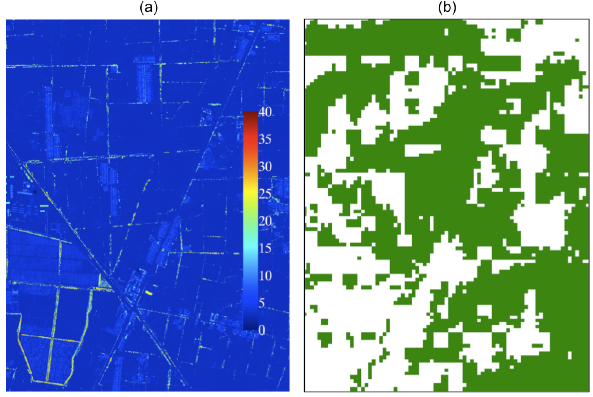
Figure 5: (a) Roughness element height from the DSM (in meters); (b) areas where both 490 Fig. 5. (a) Roughness element height from the DSM (in meters); z 0m(Raupach) and z 0m(CFD) match at ± 0.05 meters for the calculation with a N-E wind are 491 (b) areas where both z 0m ( Raupach ) and z 0m ( CFD ) match at ± 0.05m represented in green. Both figures cover the 7.2 km 2 area of interest. 492 for the calculation with a N–E wind are represented in green. Both figures cover the 7.2km 2 area of